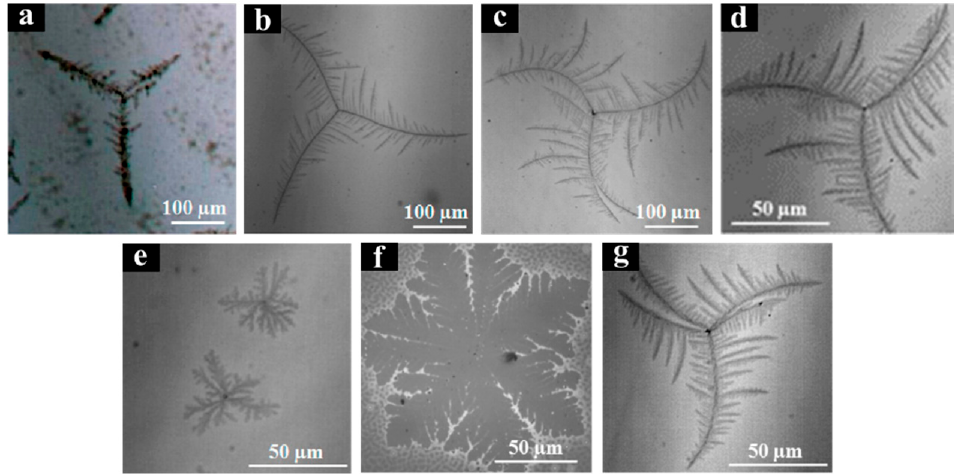
Figure 10. Optical micrographs of PLLA/poly( D -lactic acid) (PDLA) blended films (thickness ~20 nm) crystallized at 200 °C. The mass fractions of PLLA were: ( a ) 95%; ( b ) 90%; ( c ) 85.7%; ( d ) 75%; ( e ) 60%; ( f ) 50%; and ( g ) 25% [107]. Copyright 2010. Reproduced with permission from the American Chemical Society.